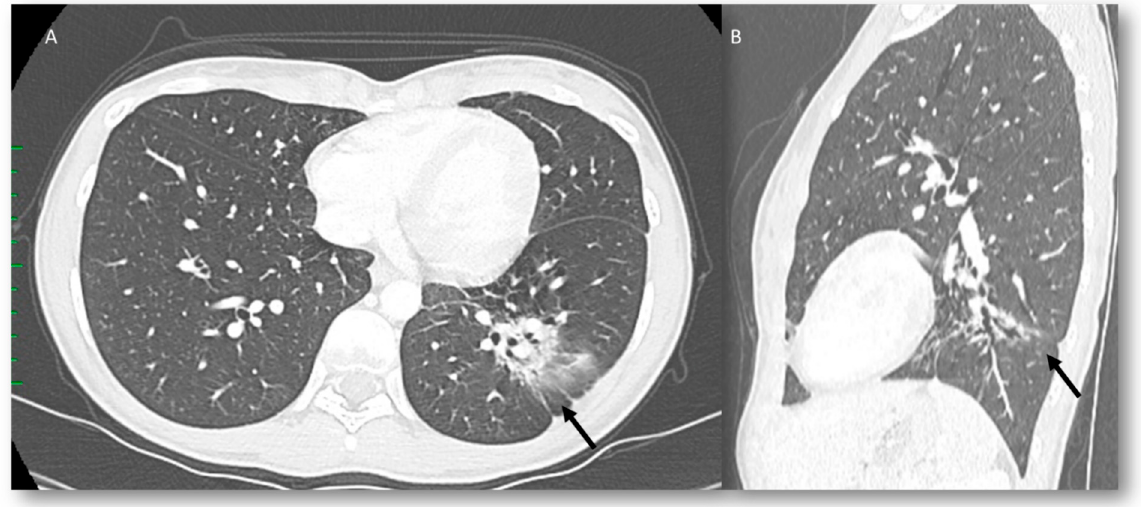
Figure 2. CT assessment (( A ): axial plane) of RRP (arrow) in radio-treated melanoma metastasis during ICI therapy; resolved (( B ): CT in sagittal plane) after steroid therapy (arrow).